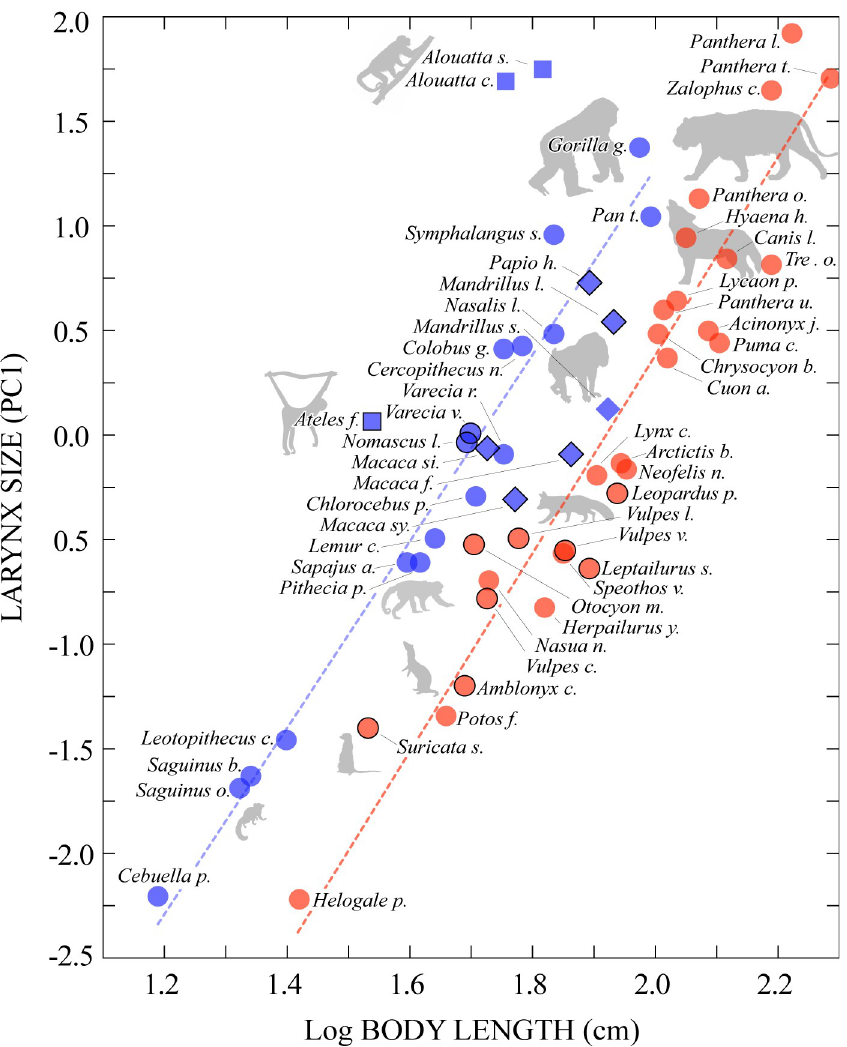
Fig 2. Body length versus larynx size. Base 10 logarithm of body length plotted against the PC1 of the larynx measurements for our sample of 26 primate (blue) and 29 carnivoran (red) specimens. Squares depict atelids and diamonds depict papionines, clades that stand out for having exceptionally large or small larynges among primates, respectively (see text). Specimens belonging to one of the eight pairs used to estimate the magnitude of the grade shift between primates and carnivorans are outlined in black. Regression lines display a significant grade shift between primates and carnivorans, as quantified by pANCOVA (see text). See Fig 3 for full species names corresponding to the abbreviated names shown here. The data used to create this figure are located in S1 Data, sheet B, columns B and C. pANCOVA, phylogenetic ANCOVA; PC1, first principal